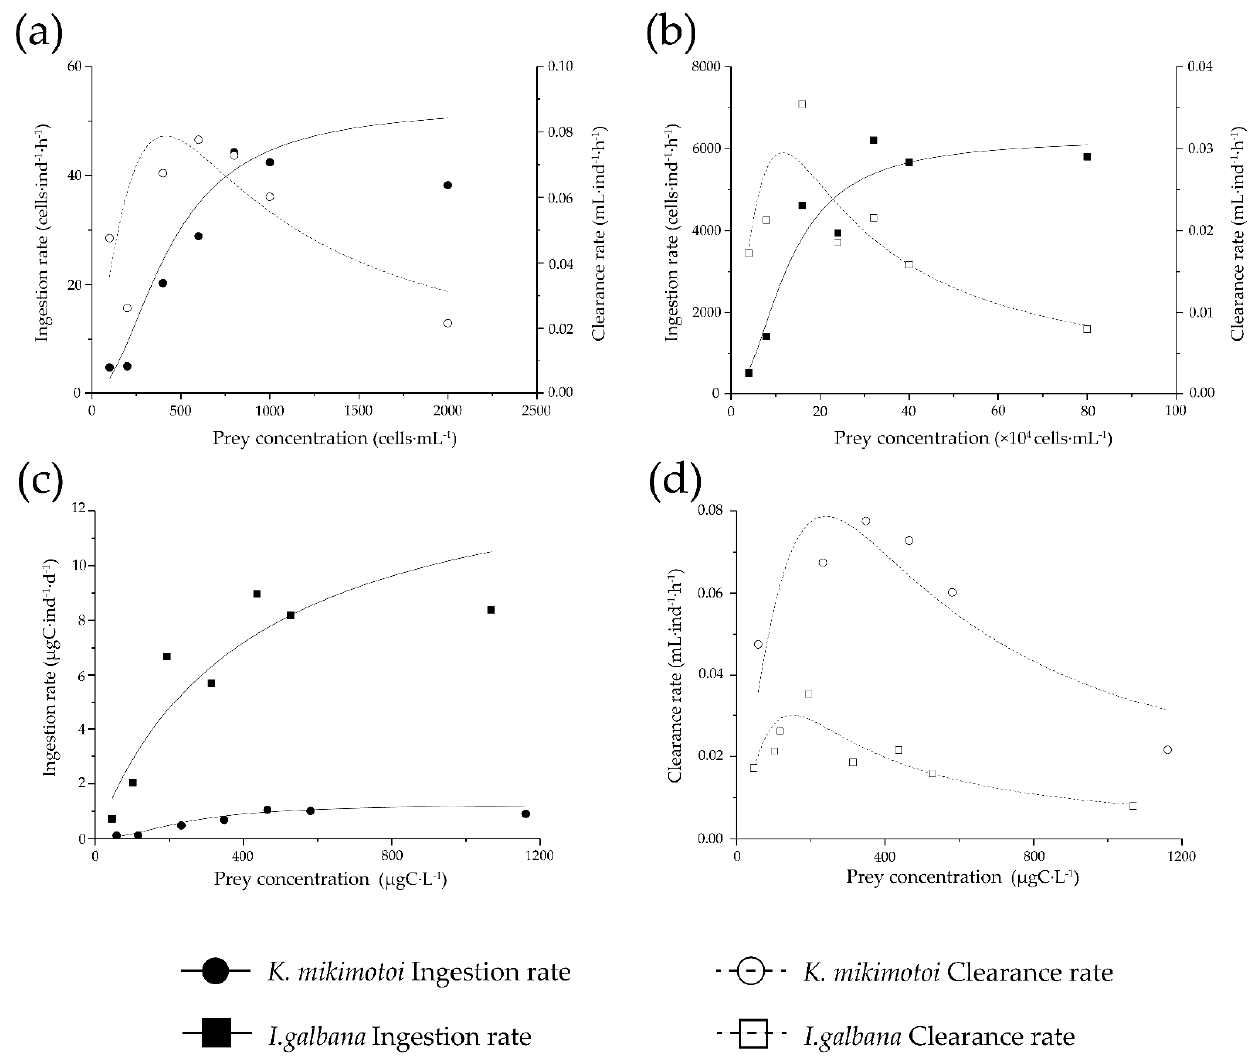
Figure 2. Functional feeding response of adult female T. japonicus on K. mikimotoi and nontoxic control prey I. galbana. Cell-density-based feeding rates of K. mikimotoi ( a ) and I. galbana ( b ). Carbon-based functional response of ingestion rate ( c ) and clearance rate ( d ). Clearance rates and ingestion rates are presented as a function of the average food concentration. Holling type III equations were fitted with the parameters provided in Table 3.